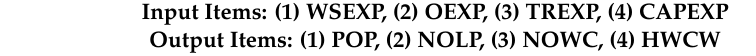
Table 7. DEA Technical Efficiency